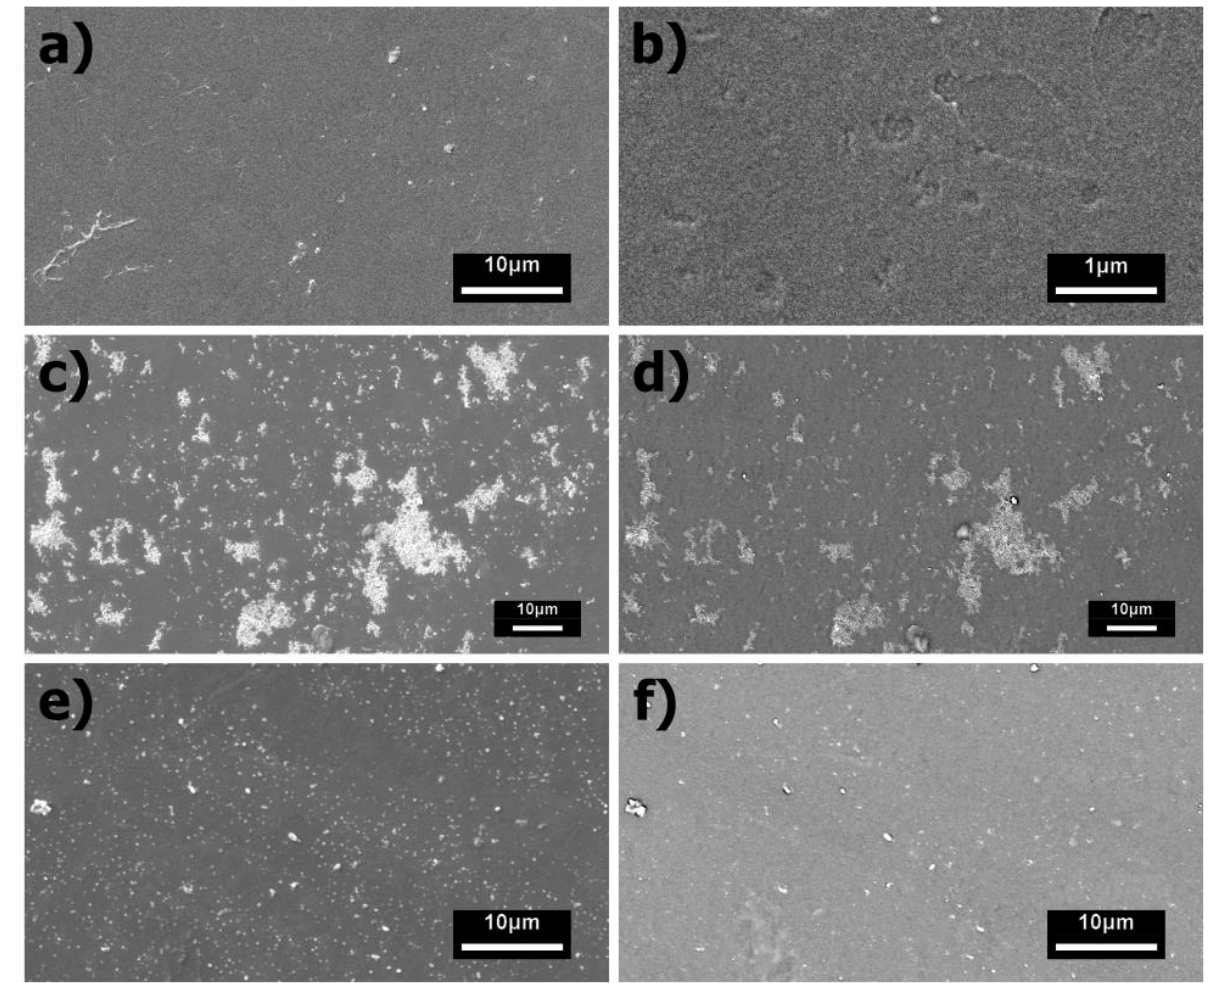
Figure 1. SEM characterization of the pristine PANI and composite films deposited over glass sub- strates when using the secondary electrons (SE) as signals for high-resolution images or backscattered electrons (BSE) to enhance the atomic number contrast between the PANI and oxide phases in the composite films. SE images of the pristine PANI films are presented in ( a , b ). SE and BSE images of the PANI/CeO 2 films are presented in ( c , d ), respectively. SE and BSE images of the PANI/WO 3 films are presented in ( e , f ), respectively.